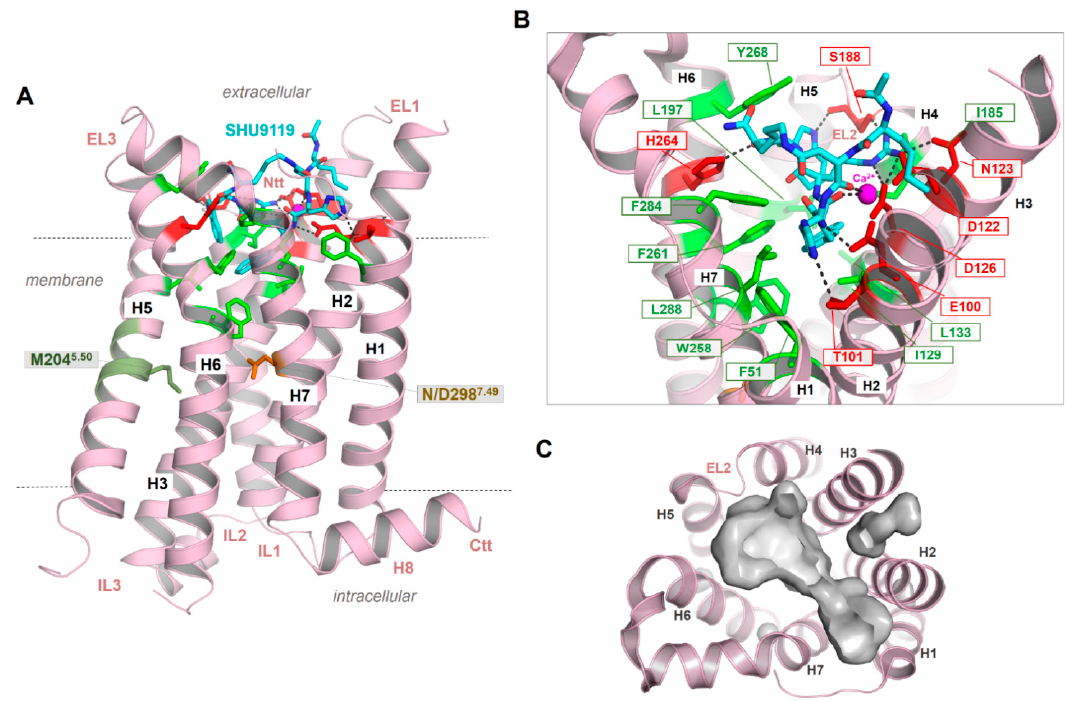
Figure 4. The crystal structure of the MC4R in an inactive state bound with the antagonist SHU9119 [21]. ( A ) The structure shows a number of important details of the MC4R, such as an unkinked helix 5. Instead of a highly conserved proline in class A GPCRs, a methionine is located at the corresponding position 5.50 (deep green). The NP 7.50 xxY motif in helix 7 (the numbers 5.50 and 7.50 are used according to the unifying numbering scheme for amino acids in the transmembrane helices of class A GPCRs proposed by Ballesteros and Weinstein [83]), which is highly conserved in class A GPCR, is a less conserved DPxxY motif in the MCR subtypes. However, in the crystallized MC4R structure, D7.49 has been mutated to an asparagine (NP 7.50 xxY) motif. The peptidic antagonist SHU9119 (cyan) binds between the EL2 and several helix-loop transitions. ( B ) SHU9119 binding is characterized by hydrogen bonds (lack dotted lines) to hydrophilic amino acid residues (red sticks) and backbone atoms in TMH 2–4 and the EL2. Further participating residues in TMH6 and TMH7 are hydrophobic and aromatic (green sticks). Experimental studies combined with electron densities (resolution of the crystal structure is 2.75 Å) between D122, D126, and E100 indicating calcium binding in this region, which is also associated with ligand binding. ( C ) The empty ligand binding pocket (inner surface, gray) reflects the dimension of this crevice, which is large in the MCRs compared to other GPCRs due to the very short EL2.